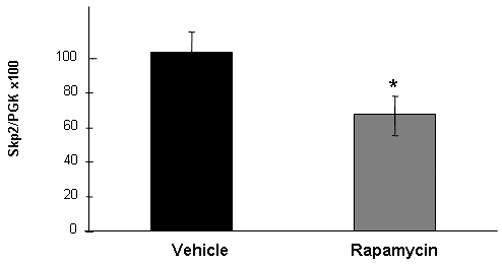
The effect of rapamycin on Skp2 mRNA levels. T47D cells were treated with rapamycin (20 nM) for 8 h and the change in Skp2 mRNA levels was determined by real-time RT-PCR. PGK, phosphoglycerate kinase.